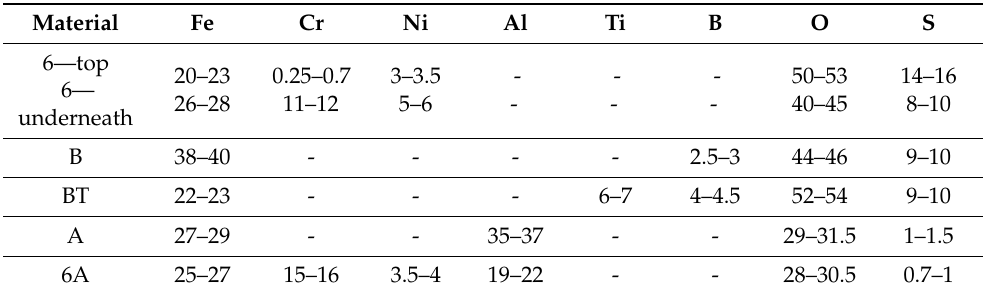
Figure 7. SEM surface morphology of steels with aluminized coatings after 504 h of exposure in H 2 S-air at 500 ◦ C. Left—aluminized carbon steel (A), Right—aluminized stainless steel (6A). Table 3. Selective EDS analysis data (wt.%) from the surfaces exposed to H 2 S–air at 500 ◦ C for 504